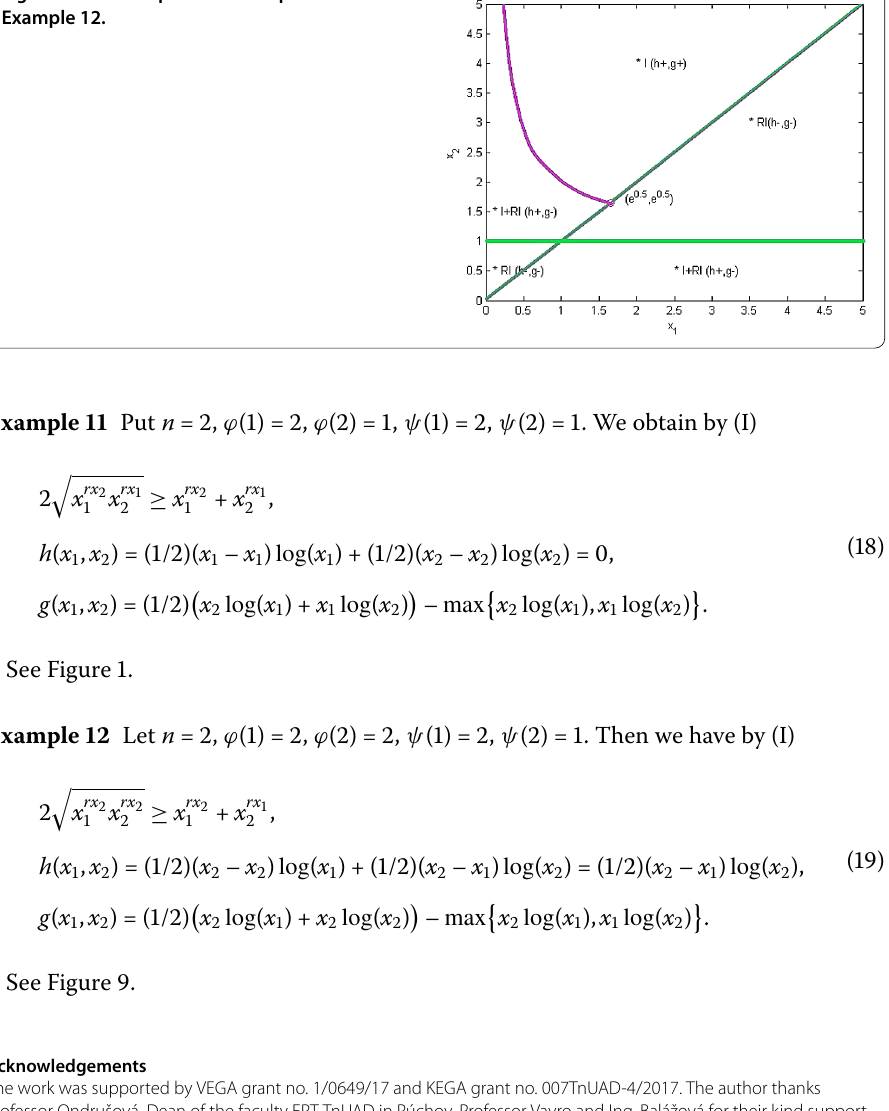
Figure 9 Solution points for inequalities Example